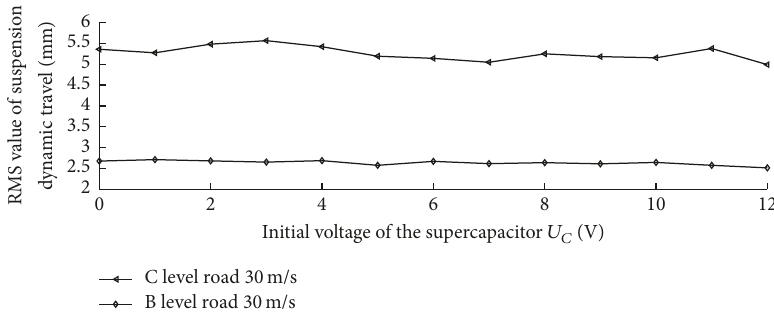
Figure 10: The relationship between suspension dynamic travel and supercapacitor initial terminal voltage.